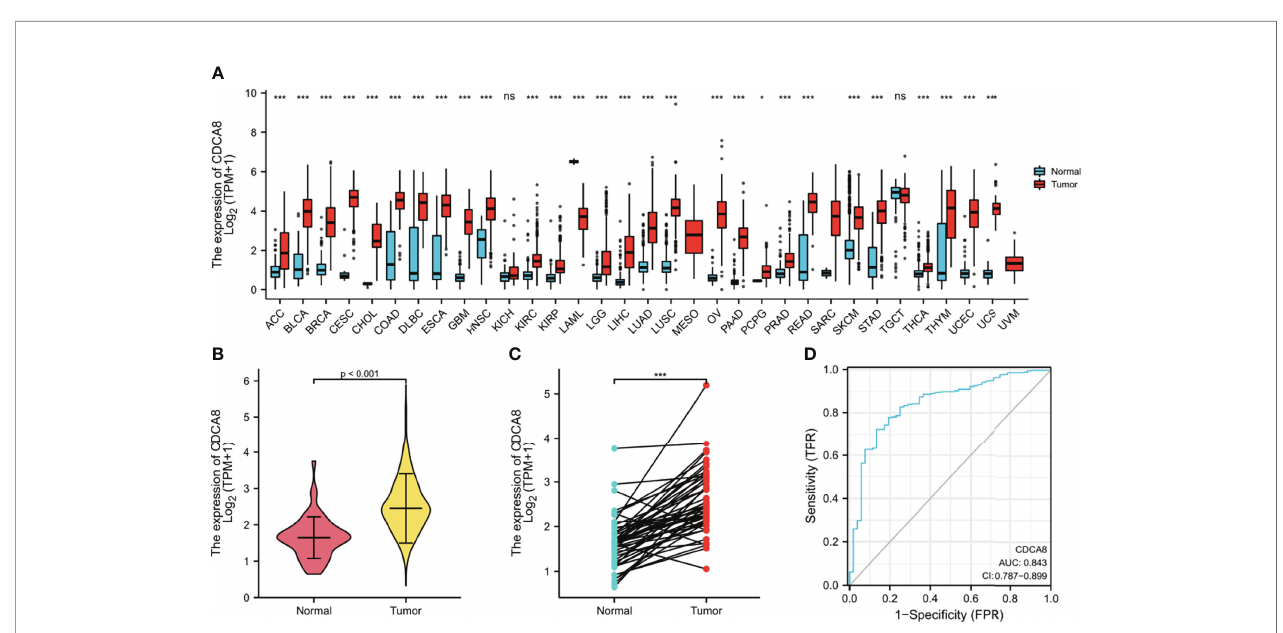
FIGURE 4 | (A) Expression of CDCA8 in pan-cancer. (B, C) Differential expression analysis of CDCA8 between prostate cancer and normal tissues in TCGA database; (D) Sensitivity and speci fi city of CDCA8 in the diagnosis of PCa. ns P > 0.05; *P < 0.05; **P < 0.01; ***P <